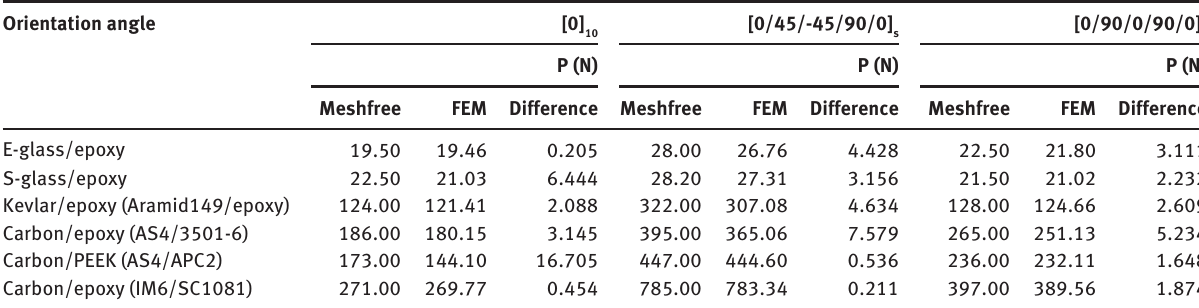
Table 4 Results of the meshfree and finite element methods